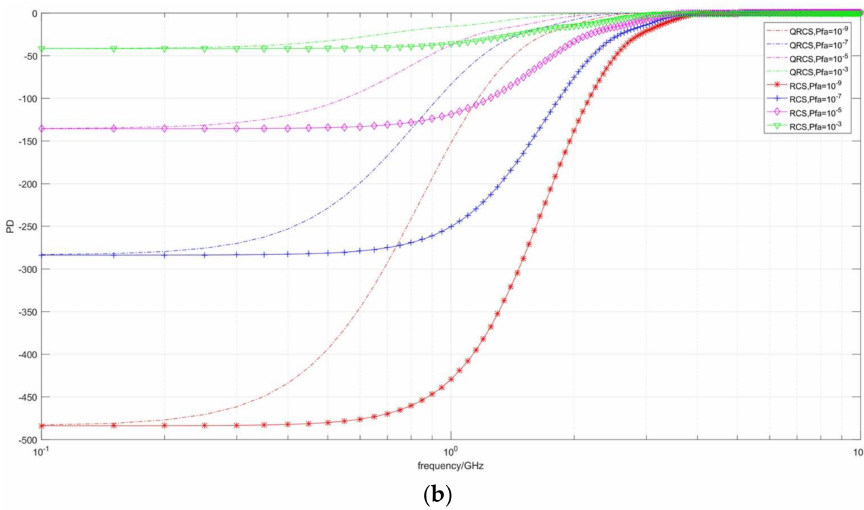
Figure 8. Correlation diagram of detection probability changing with frequency (taking P fa ). ( a ) P D /%, ( b ) P D